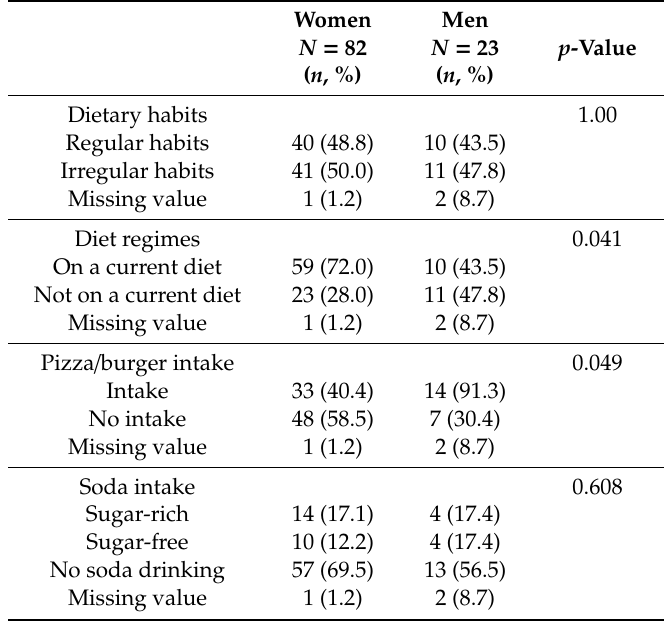
Table 3. Di ff erences in dietary patterns between women and men during the four-day run-in period.